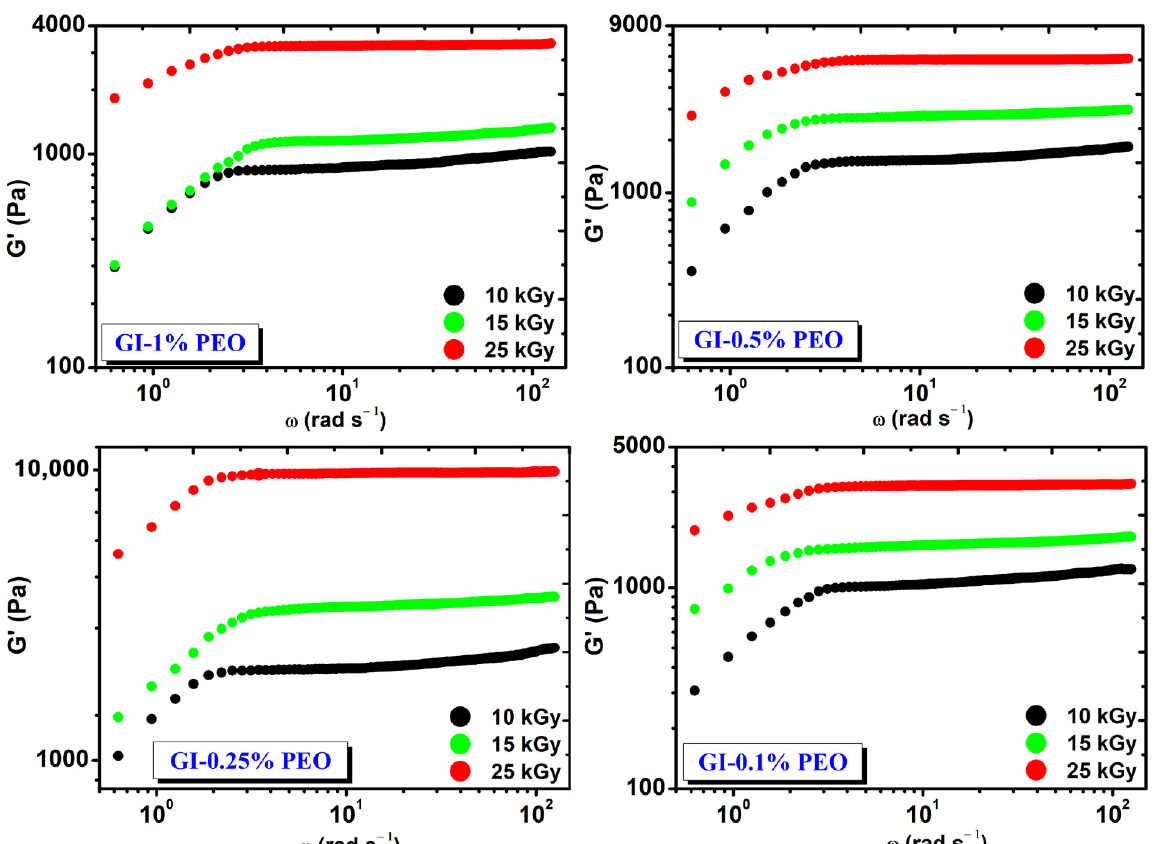
Figure 2. The variation of G ′ depending on the angular frequency ( ω ) and the absorbed dose. At the absorbed dose of 25 kGy, the modulus G ′ had values between (3241–9816) Pa and depended on the PEO concentration, having the highest value at 0.25% PEO. Figure 3 shows the variation of the elastic modulus (G ′ ) as a function of PEO concen- tration.